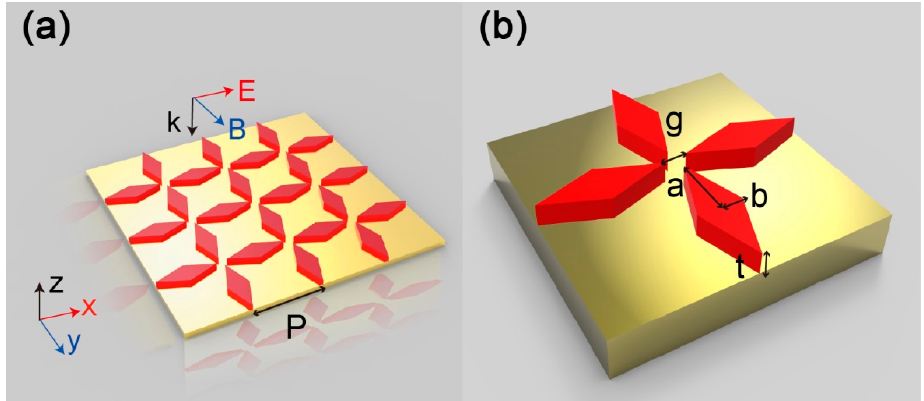
Figure 1. ( a ) Perspective views of the DBMPA, the upper red for Si, the lower for Au; ( b ) a unit cell, in which the thickness of the Au film is 100 nm, the thickness (t) of the Si resonator is 70 nm, the period (P) is 240 nm, the resonator is diamond, the semi-major axis (a) is 110 nm, the semi-minor axis (b) is 40 nm, and the gap (g) between the adjacent resonators is 20 nm. The tunable DBMPA can be further obtained by changing the structural parameters in the figure.